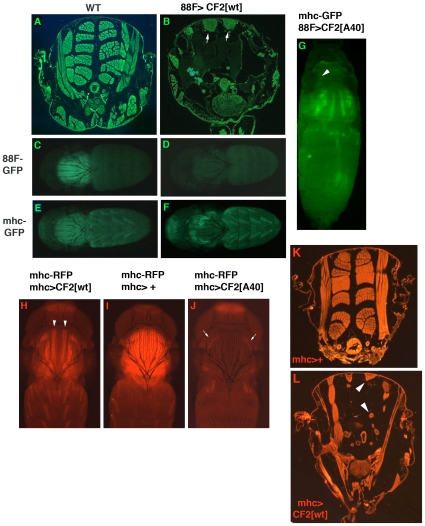
CF2 gain of function disrupts IFM development.A) Cross section of the thorax of an 88F-GAL4[81B-13]/CyO fly (wild type control). B) Cross section of the thorax of an 88F-GAL4[65-9]/UAS-CF2-II[wt]) fly. White arrows point to the remnants of the two dorsal-most dorsal longitudinal muscles C) Expression of an 88F-GFP marker in wild type IFM (genotype 88F-GAL4[81B-13]/CyO). D) Expression of an 88F-GFP marker in IFM of fly overexpressing wild type CF2 (genotype 88F-GAL4 [81B-13]/+; UAS-CF2-II[wt]). E) Expression of a mhc-GFP marker in wild type IFM (genotype 88F-GAL4[65-9]/TM3, Sb). F) Expression of a mhc-GFP marker in IFM of fly overexpressing wild type CF2 (Genotype 88F-GAL4[65-9]/UAS- CF2-II[wt]). G) Defects in muscle development in a 88F-GAL4[65-9]/UAS-CF2-II[A40] pupa. The age can be approximated by the presence of pigment in the eye (indicated by the arrowhead. H) Pharate adult expressing UAS-CF2[wt] via a mhc-GAL4 driver. Arrowheads point to thinner IFMs. I) Control mhc-GAL4, mhc-RFP animal, at the same stage as H and J. J) Pharate adult expressing UAS-CF2[A40] via a mhc-GAL4 driver. Arrows indicate the anterior remnants of the IFM. K) Section through the thorax of a control fly expressing the mhc-GAL4 driver. L) Thoracic section of a fly expressing UAS-CF2-II[wt] via the mhc-GAL4 driver. Arrowheads point to two of the abnormally thin dorso-lateral IFM.